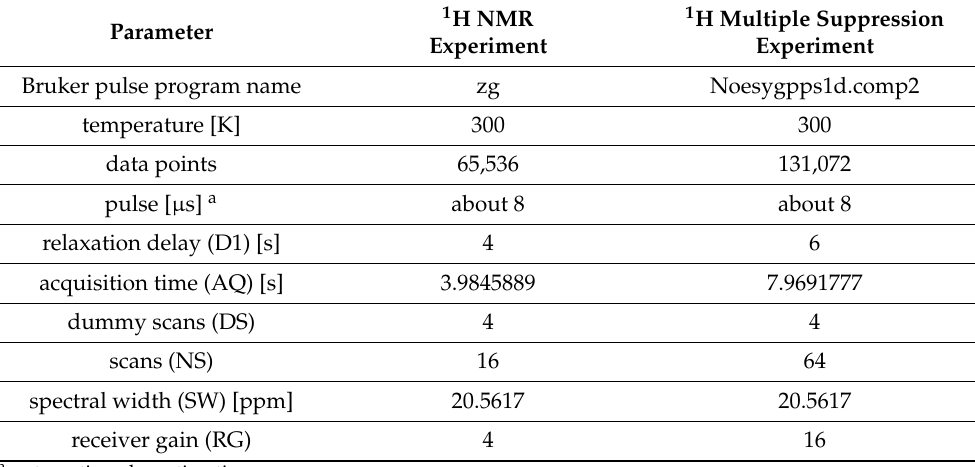
Table 2. Acquisition parameters of the developed multiple suppression NMR